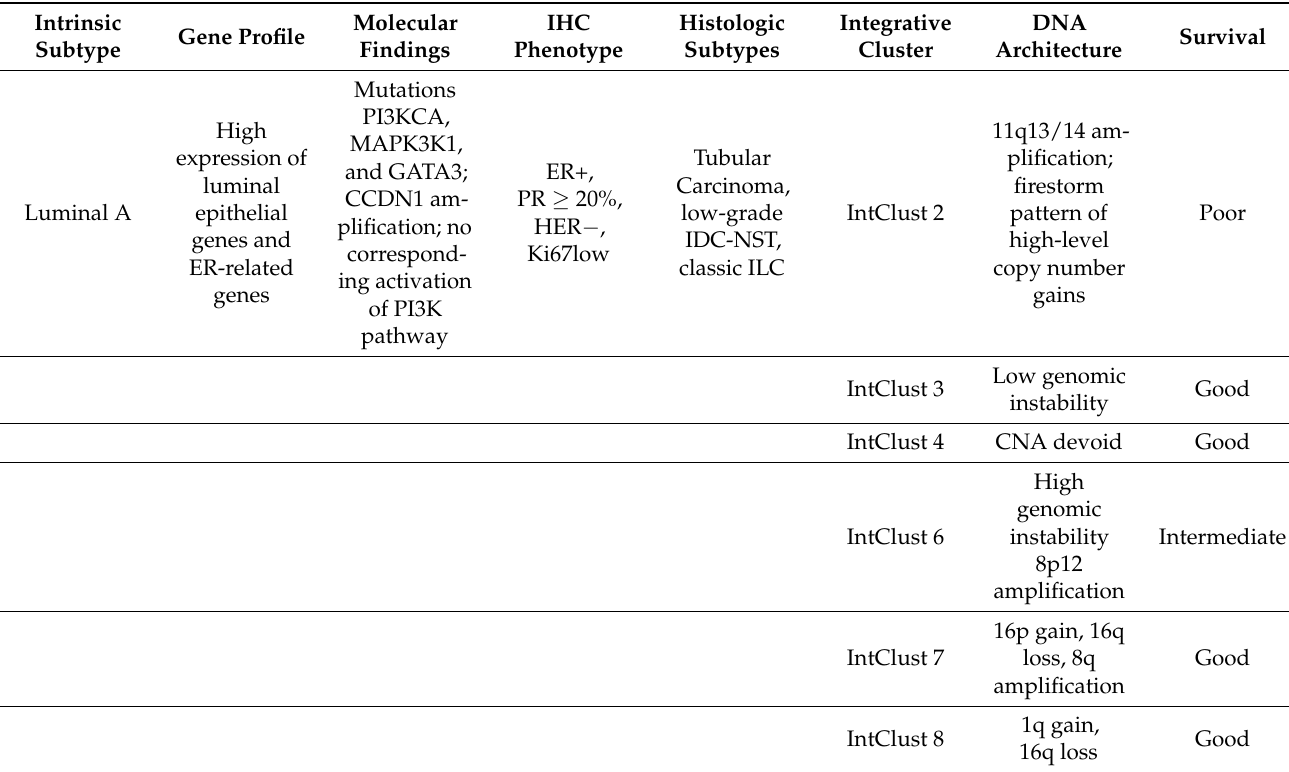
Table 3. Overview of different BC molecular